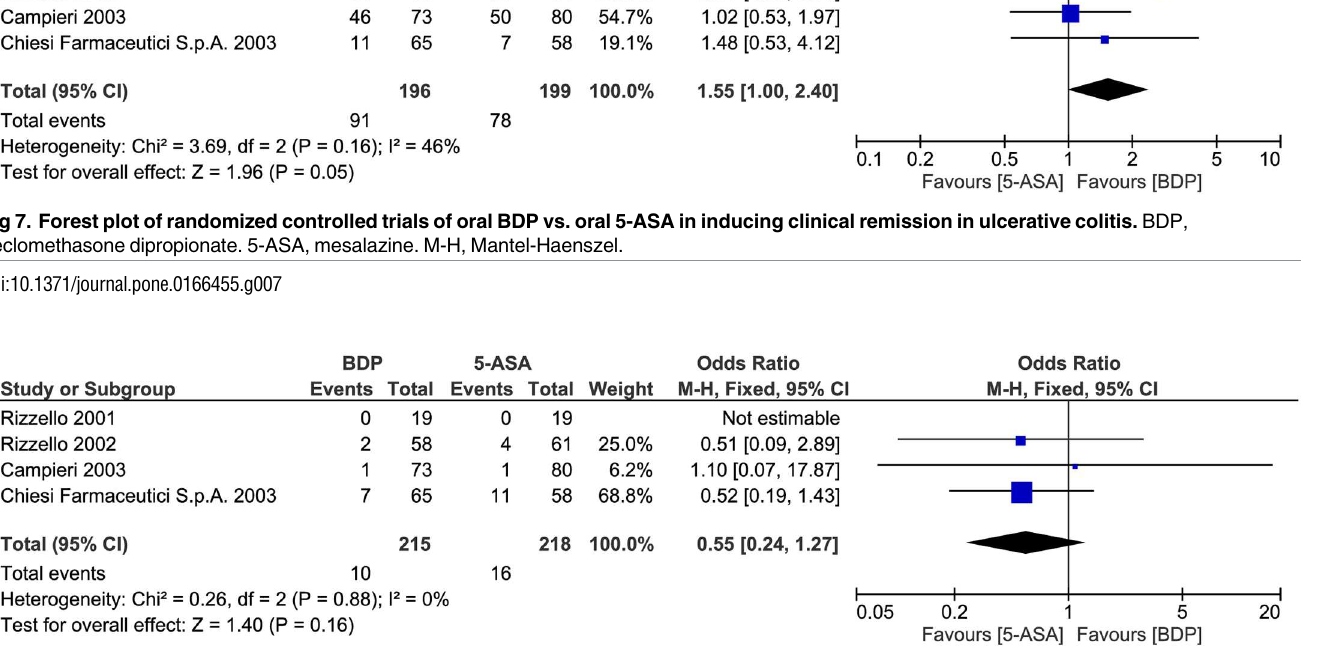
Fig 8. Forest plot of randomized controlled trials of oral BDP vs. oral 5-ASA on adverseevents appearancein ulcerative colitis. BDP, beclomethasone dipropionate. 5-ASA, mesalazine.M-H,